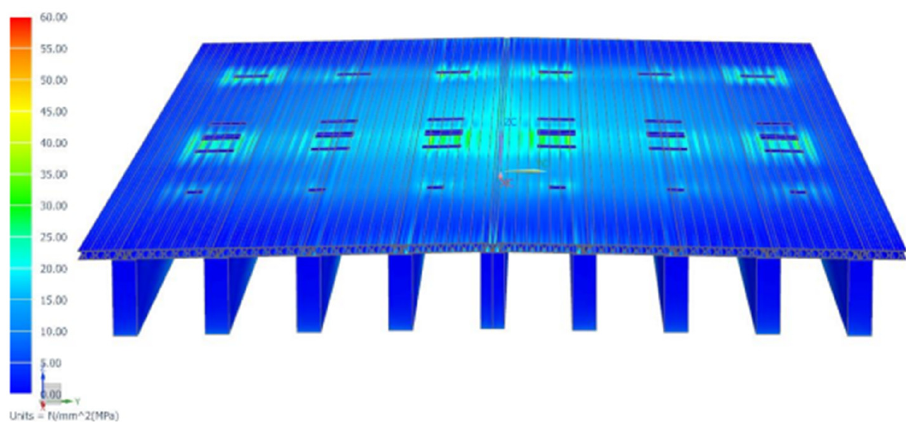
Figure 6. Distribution of the von-Mises stress on the aluminum deck under the ultimate limit state.